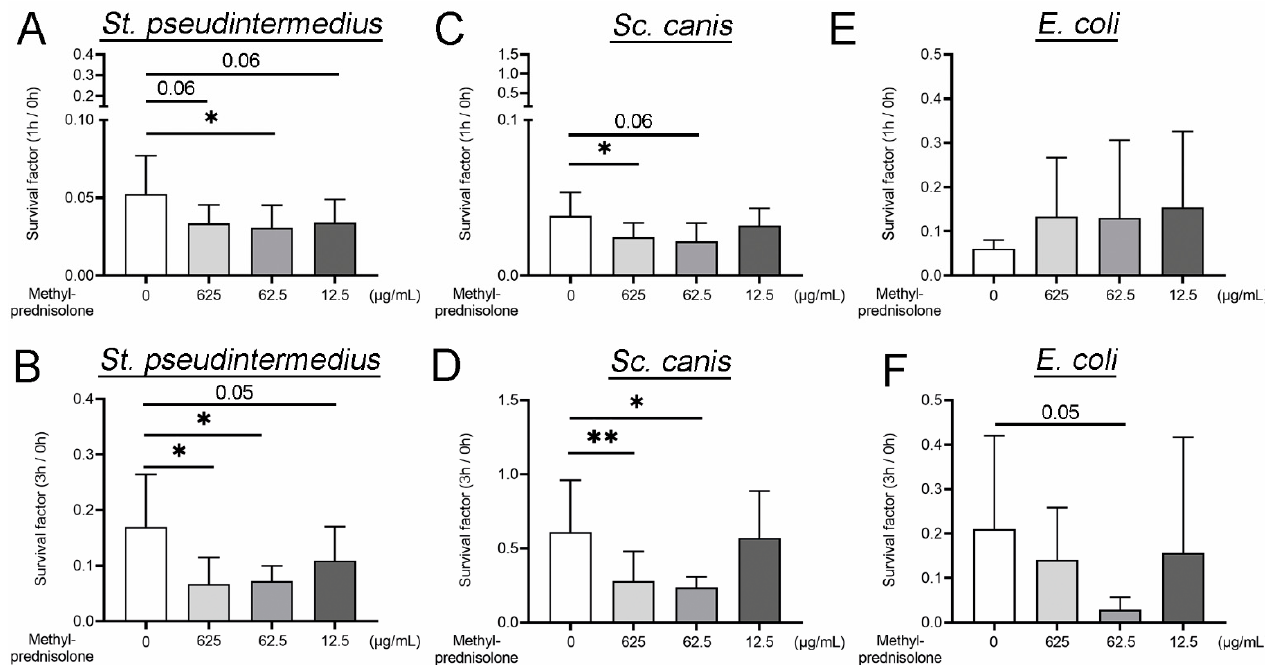
Figure 1. Methylprednisolone enhances neutrophil killing of Gram positive bacteria. The survival factor (SF) of bacteria were determined in the presence of methylprednisolone treated and untreated canine neutrophils. ( A , B ) SF of St. pseudintermedius was significantly decreased by 62.5 µ g/mL methylprednisolone treatment after one hour of incubation ( n = 4) and by 625 and 62.5 µ g/mL methylprednisolone treatment after three hours of incubation ( n = 5). ( C , D ) One hour after incubation, the SF of Sc. canis was significantly decreased by a methylprednisolone concentration of 625 µ g/mL ( n = 4). Methylprednisolone concentrations of 625 and 62.5 µ g/mL decreased after three hours significantly the SF ( n = 5). ( E , F ) The killing efficiency of neutrophils for E. coli was not significantly influenced by methylprednisolone over time at all (one hour: n = 4; and three hours: n = 5). Only after three hours of incubation, a statistical result with a p value of 0.05 was detected ( n = 5). All graphs show the mean ± SD and statistical differences were detected by one-tailed paired Student’s t -test. Statistical results are presented for values lower than 0.1 and higher than 0.05 as an Arabic number and as the following: *, p < 0.05; **, p < 0.01.